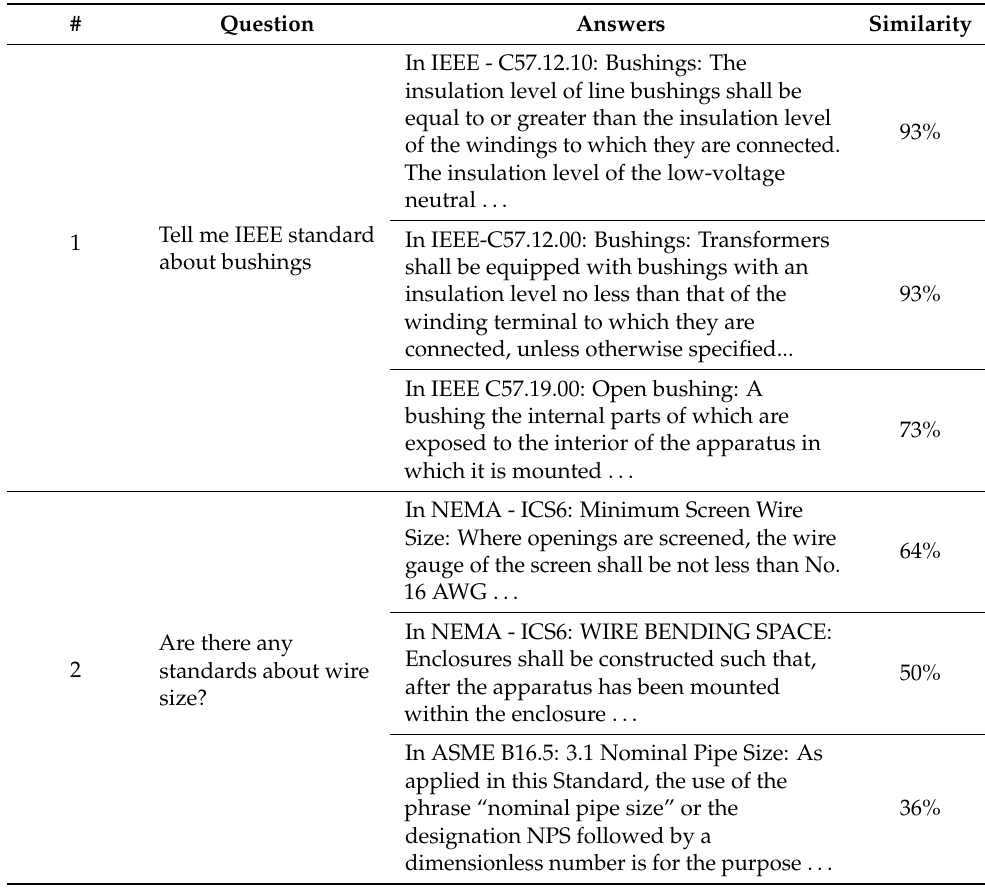
Table 4. Examples of questions and answers related to international